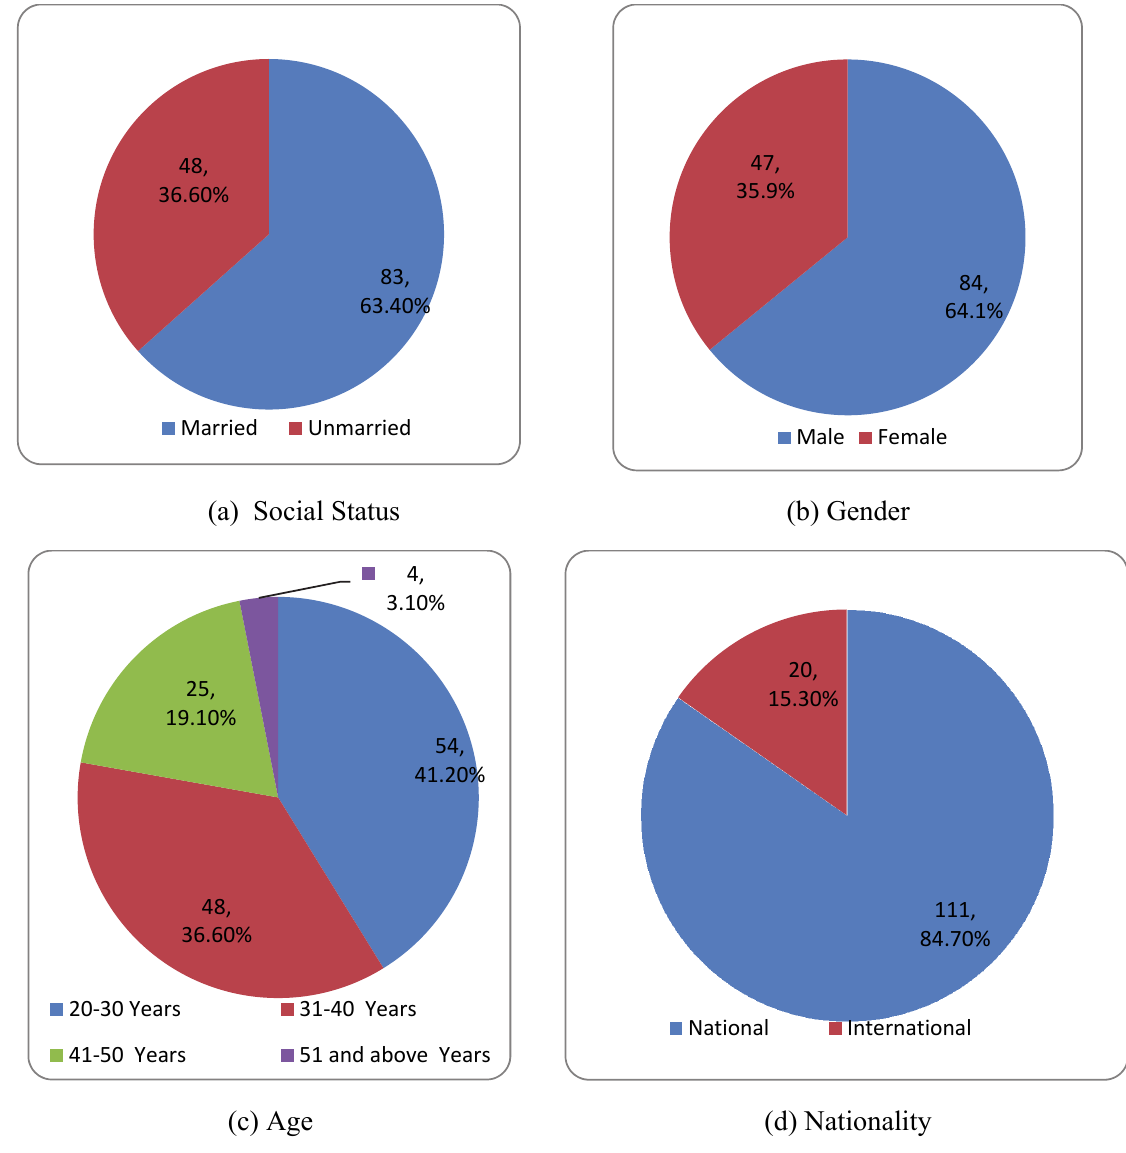
Fig. 1. Personal characteristics of the